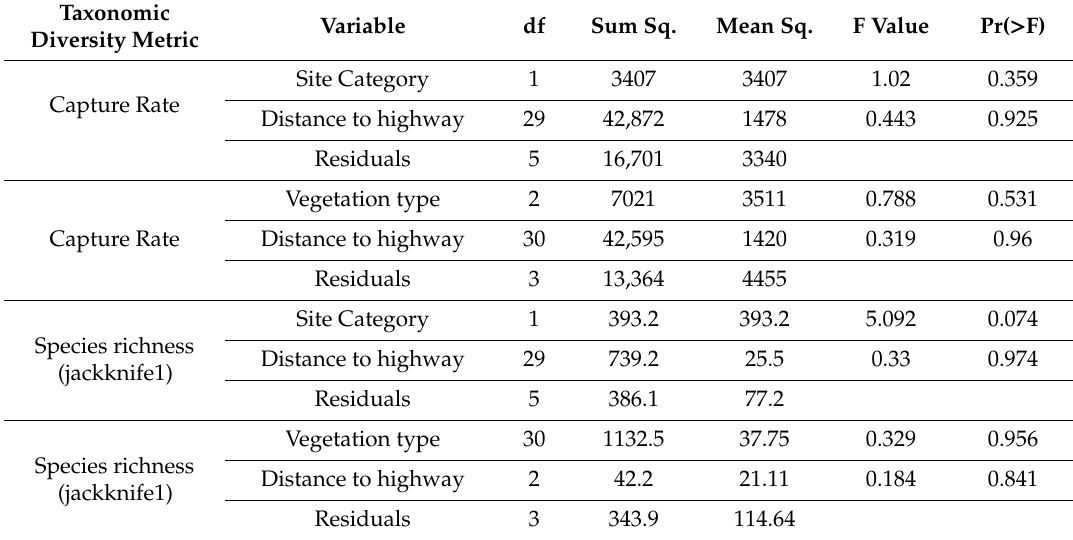
Table A1. Analysis of variance for estimated richness (Jackknife 1) and capture rate including distance to highway as a variable.